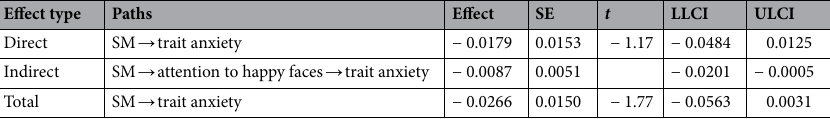
Table 5. Mediation model for the effect of social management on trait anxiety (STAI) via attention to happy faces (dwell time on happy faces). SM, social management; SE, standard error; LLCI, lower limit confidence interval; ULCI, upper limit confidence